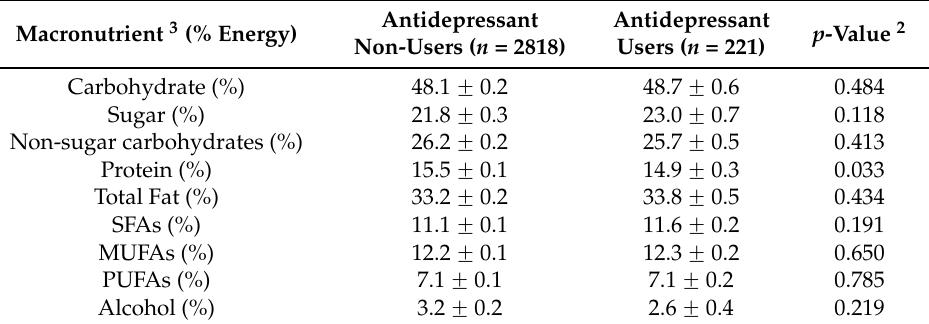
Table 2. Diet Composition by Antidepressant use from the 2005–2006 NHANES.